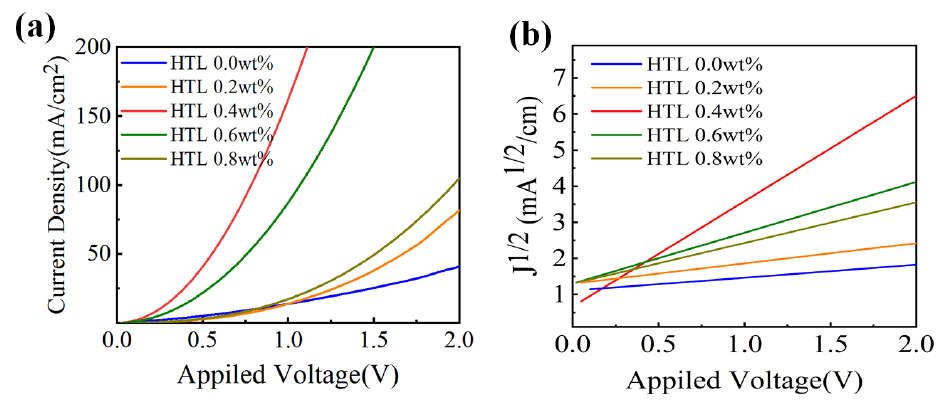
Figure 8. ( a ) J-V and ( b ) J 1/2 -V curves in hole only devices with the structure of ITO/PEDOT: PSS (40 nm)/Spiro-OMeTAD (200 nm)/MoO 3 (10 nm)/Cu.